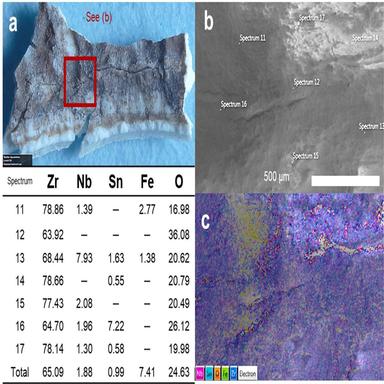
a) Optical image of EDS sample; b) location of point EDS measurements listed in the table; c) EDS map of Zr, Nb, Sn, Fe, and O.